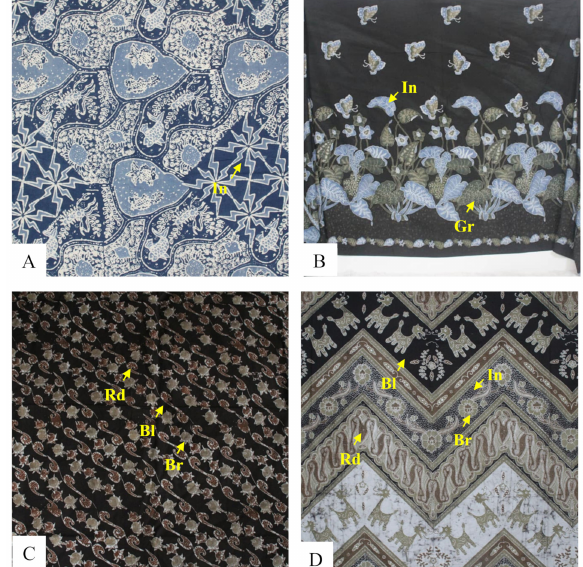
Figure 2. Various natural batik of the Zie Batik products by organic material-based natural dyes: ( A ) batik mina (fish motif), one natural dye; ( B ) caladium leaves and butterfly motifs, three natural dyes; ( C ) parang mangrove motif, three natural dyes; and ( D ) Warak Ngendhog motif, four natural dyes. In each batik, the main colors were indigo (In), green (Gr), red (Rd), black (Bl), and brown